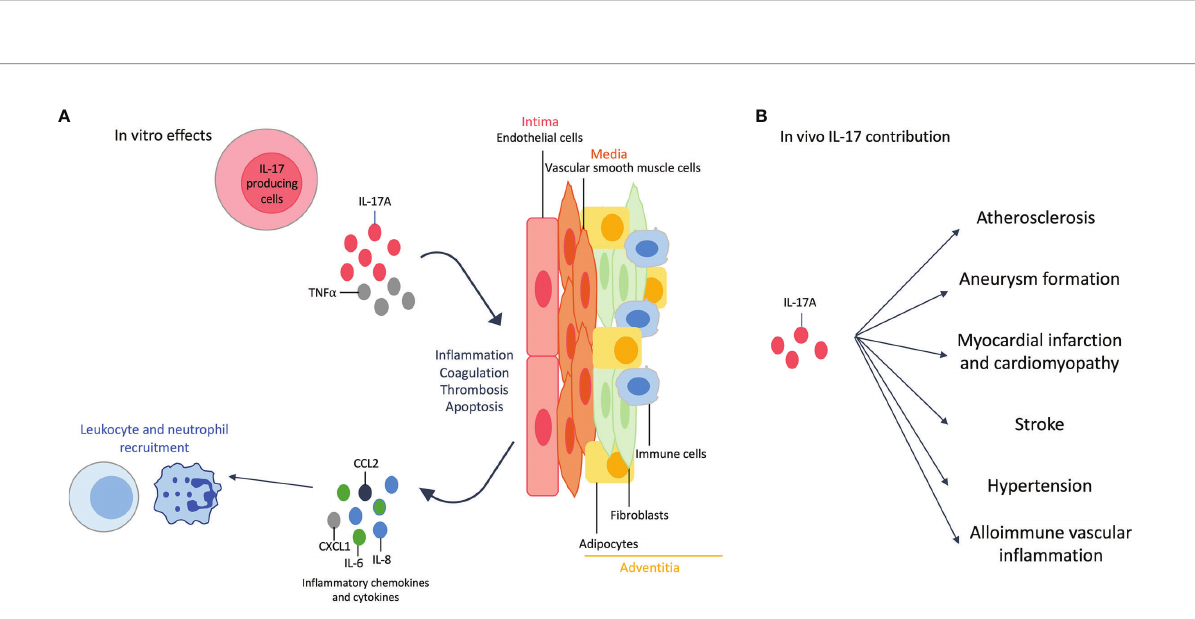
FIGURE 1 | Overview of the Th17 pathway. T-helper (Th) 17 cells undergo differentiation from Th0 cells. The fi rst step involves transforming growth factor (TGF)-ß and interleukin (IL)-21 that initiate the differentiation. Next, IL-6 and IL-1ß amplify the Th17 lineage and fi nally, IL-23 is required to maintain the lineage and to acquire its pathogenic role. Th17 differentiation can be shifted towards regulatory T (Treg) cells depending on cytokine environment. Developmental pathways of both cells are interconnected and reciprocally inhibited. Treg lacking exon 2 of FoxP3 impairs the Th17/Treg balance with increase amount of IL-17 + T cells. These D exon 2 FoxP3 Treg cells, and some Tregs in in fl ammatory conditions, can also produce IL-17. Moreover, IL-17A/F/AF are produced by Th17 cells but also by other immune cells. These cytokines bind the same receptor, activate different pathways and fi nally induce in fl ammation. IL-17 function is regulated positively or negatively by different mediators.